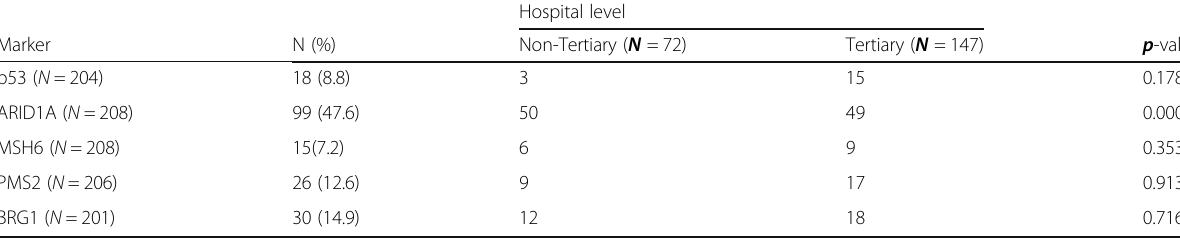
Table 3 IHC markers with no internal positive controls and level of the hospital